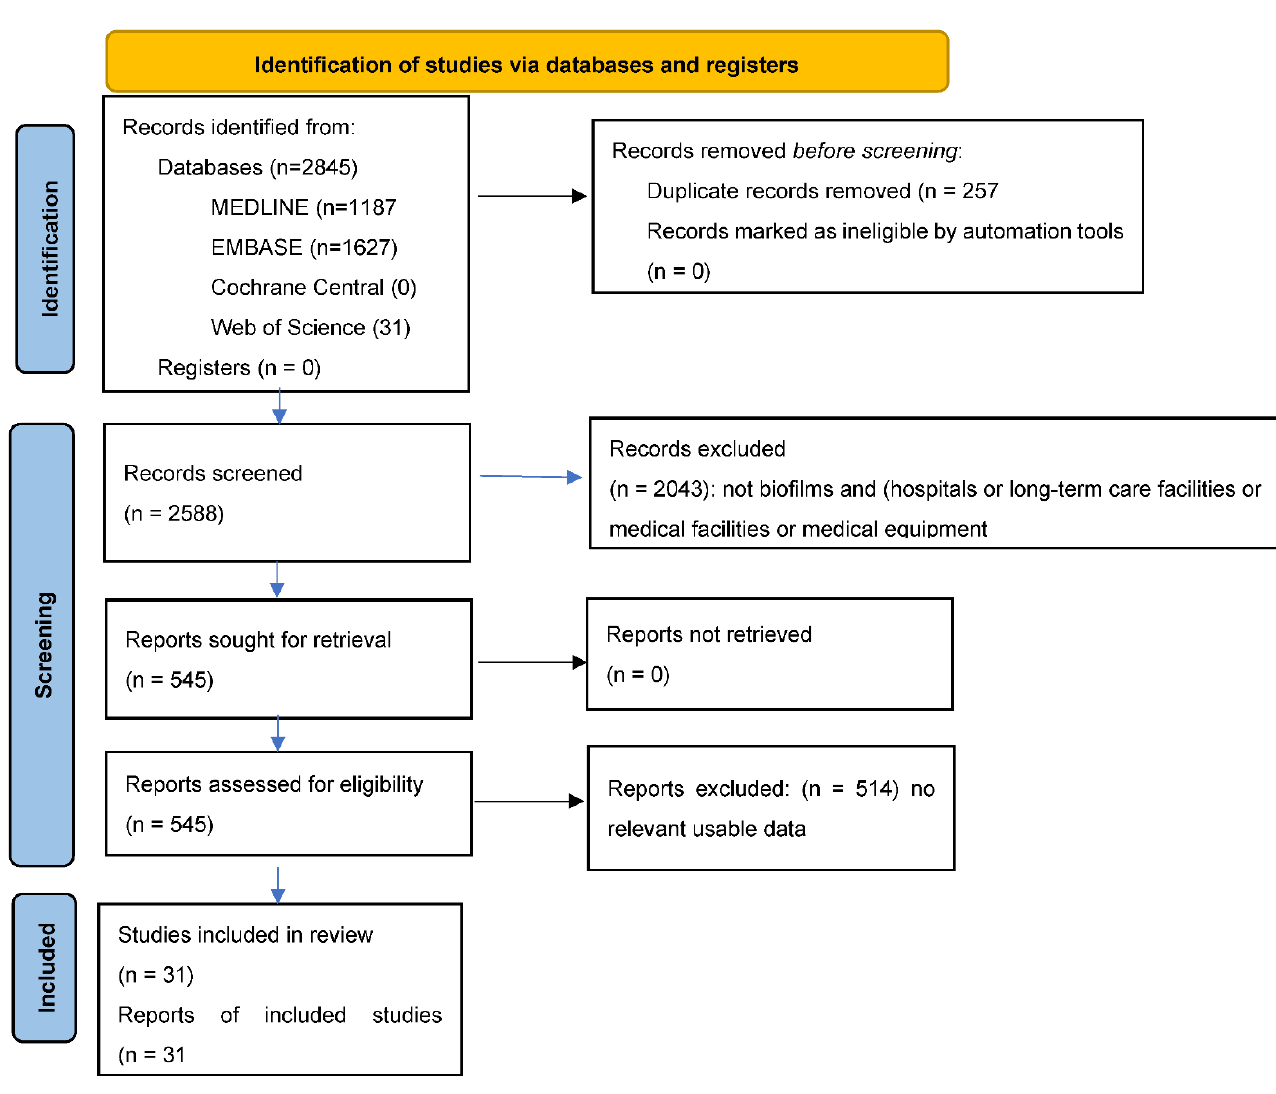
Figure 1. PRISMA Flow diagram for new systematic reviews which include searches of databases and registers only.